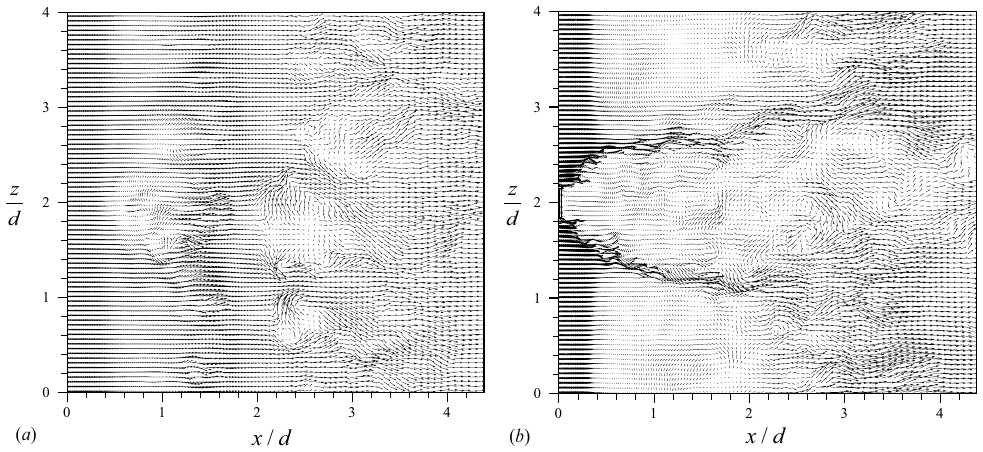
Figure 8. Instantaneous velocity vector fields on the x – z plane at y / d = 0.6: ( a ) cylinder without a tab; ( b ) cylinder with tabs of l y / d = 0.2 and l z / d = 0.3. Note that the x – z plane at y / d = 0.6 is located slightly above the